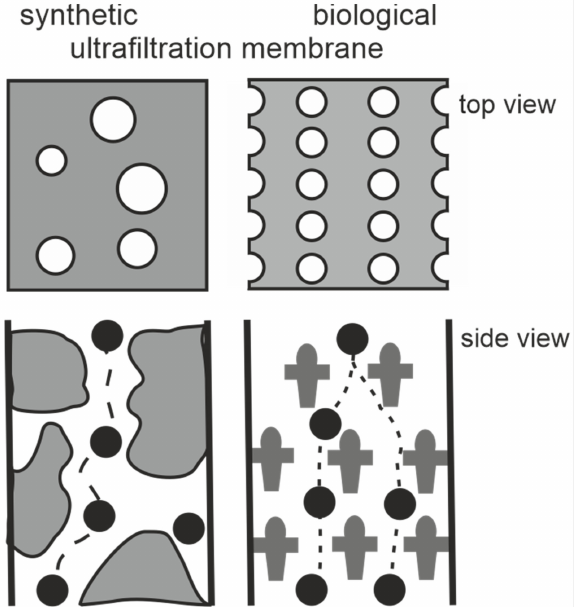
Figure 2. Schematic drawing of synthetic and S-layer ultrafiltration membrane. Left: The active ultrafiltration layers of most synthetic membranes show a porosity of up to 10%. Right: Crystalline S-layers reveal a porosity of up to approx. 70%. Although the active ultrafiltration layer is usually composed of several closed associated monolayers, the rejection characteristics is exclusively deter- mined by the sieving properties of the individual S-layer protein monolayers. (Adapted from [8]. Copyright © 1986 with permission from